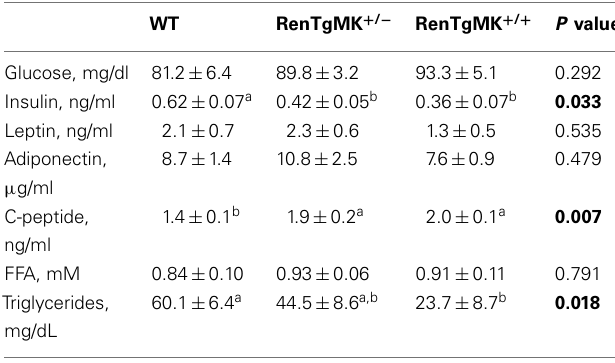
Table 1 | Serum metabolic markers in male wild-type and RenTgMK